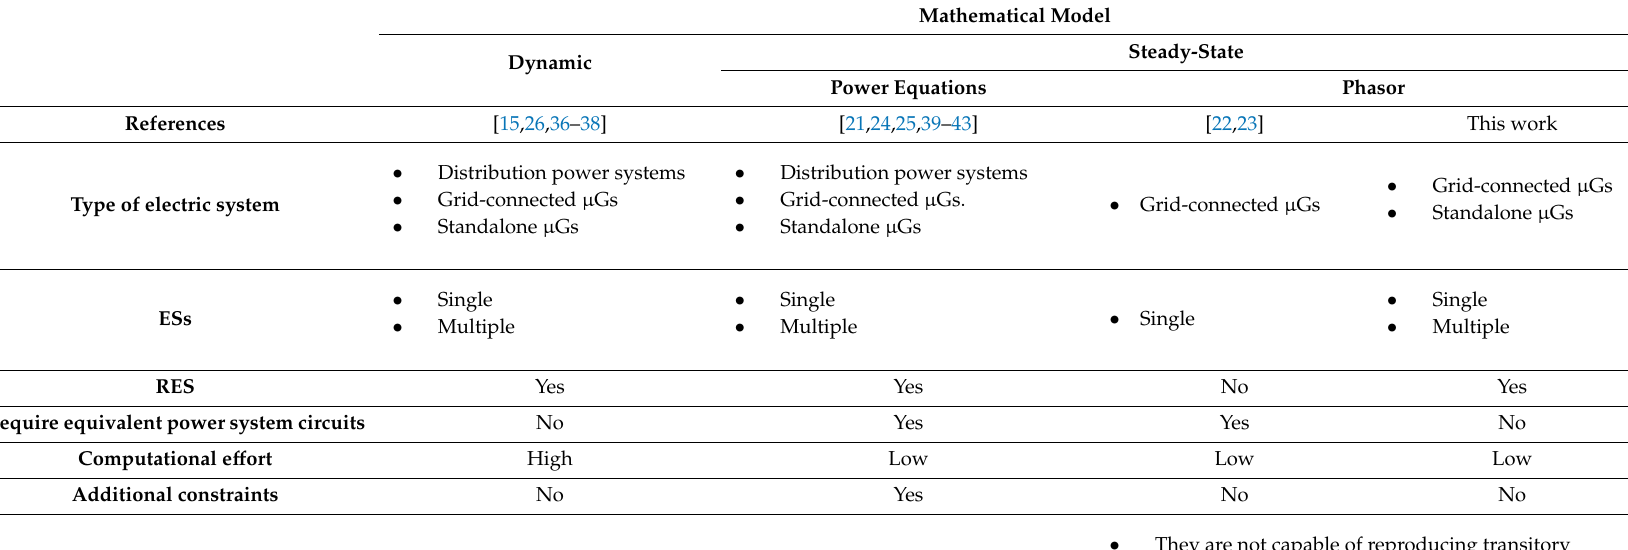
Table 5. Comparative analysis of the mathematical models for the ES applied in electrical